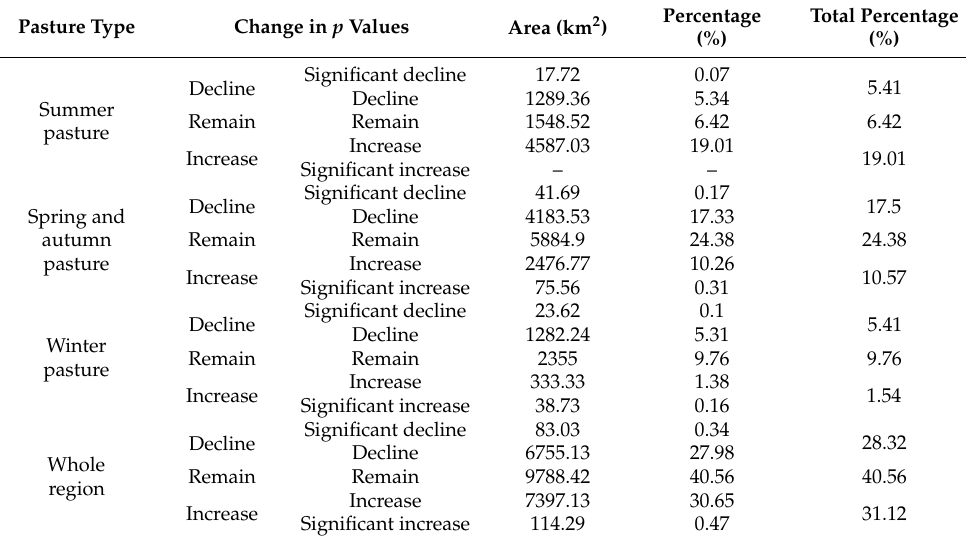
Figure 6. Changes in MODEI from 2008–2018 in Fuyun County. ( a ) 2008; ( b ) 2018. Table 6. Changes in MODEI in Fuyun County between 2008 and